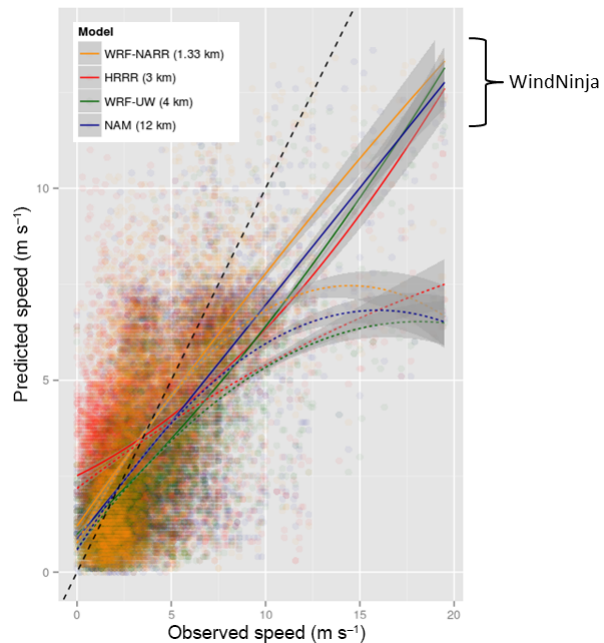
Figure 2. Observed vs. predicted wind speeds for the 5-day eval- uation period at Big Southern Butte. Dashed black line is the line of agreement. Colored lines are linear regressions (quadratic fit); dashed lines are NWP models and solid lines are NWP forecasts downscaled with WindNinja. Shading indicates 95% confidence in-